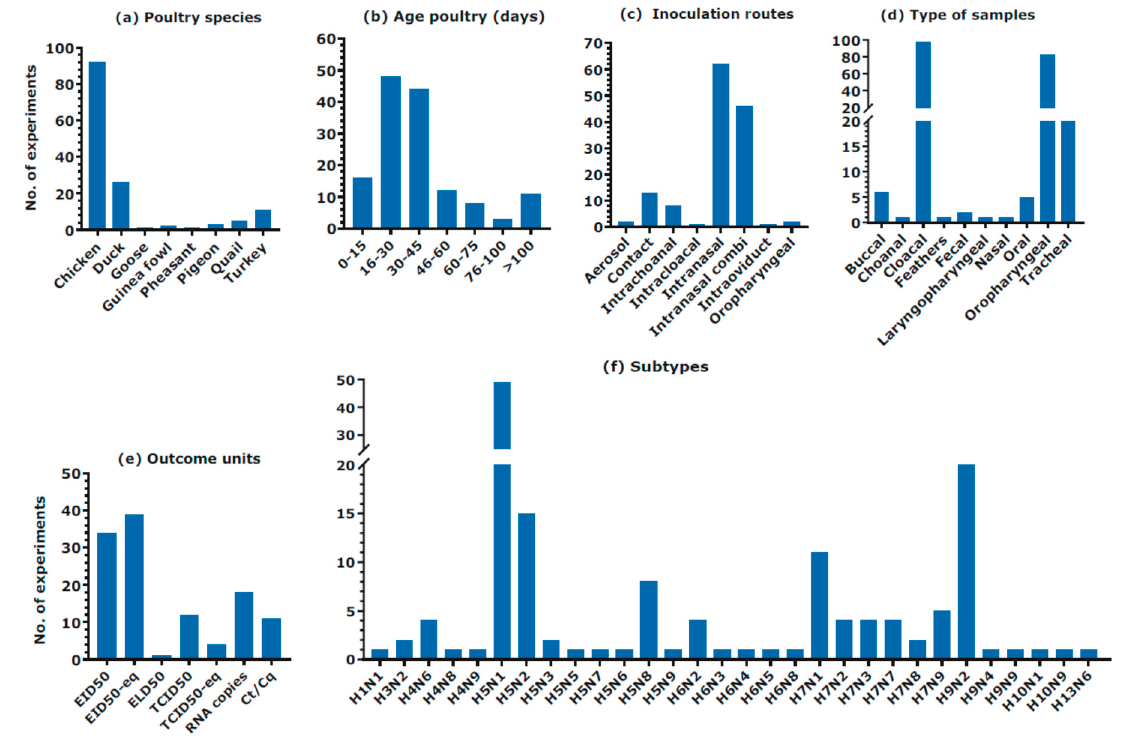
Figure 2. An overview of the qualitative analysis. The different studied poultry species, ages, inoculation routes, types of samples, outcome units and virus subtypes in the included studies. Some studies used multiple variables. “Intranasal combi” is a collective term for all different intranasal combinations e.g., intranasal and ocular inoculation.